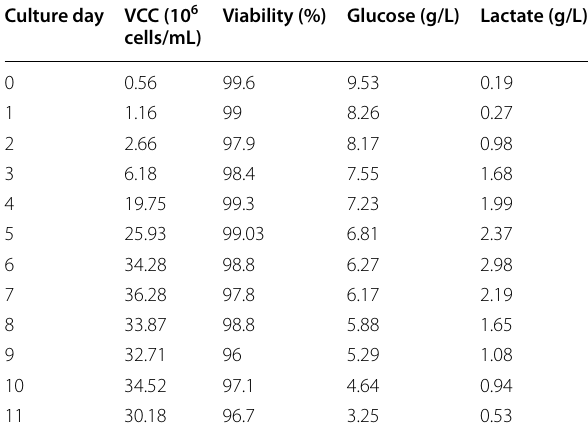
Table 2 Cell count and viability on different days of bioreactor process